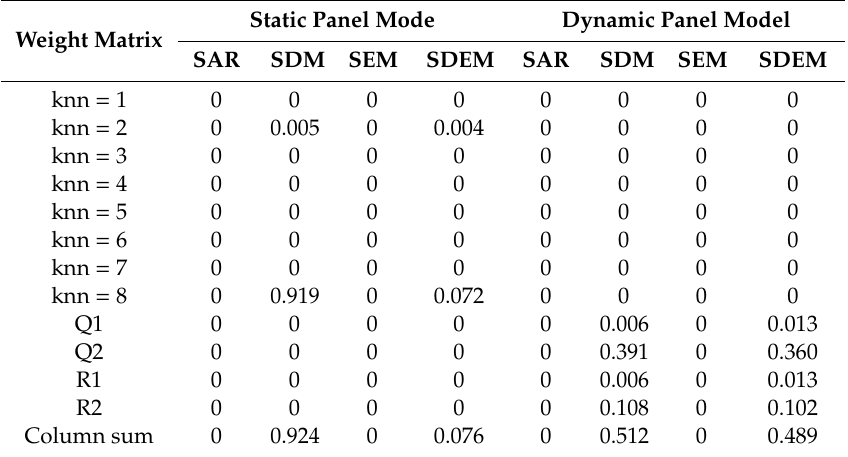
Table 5. Bayesian posterior probability optimal model selection